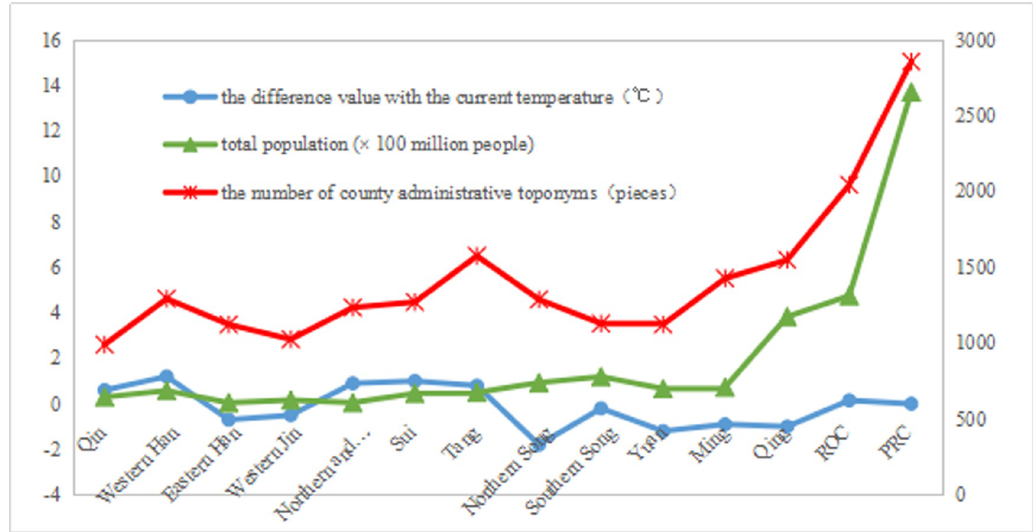
Fig 15. Trend chart of toponym, population, and temperature changes. The temperature values in Fig 15 are the change values with the current temperature. For historical population data, we referred to the statistical data from the National Earth System Science Data Sharing Infrastructure, National Science & Technology Infrastructure of China, and made some